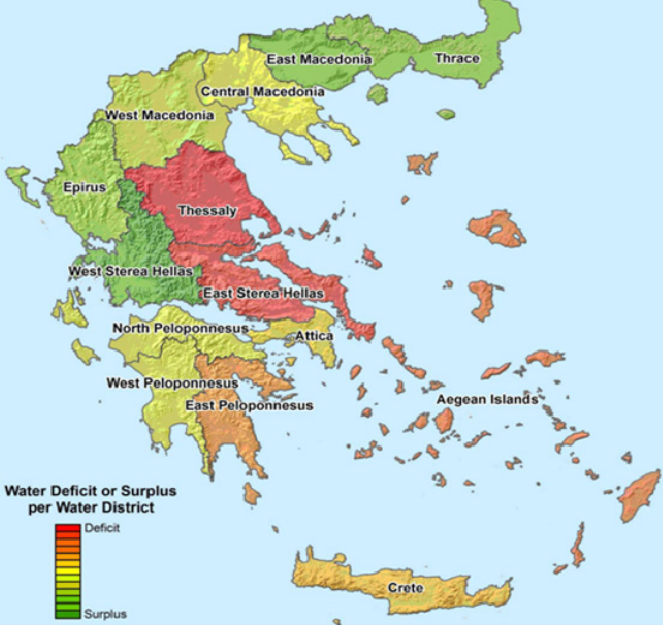
Figure 4. Deficit and/or surplus of potable water per water district in Greece [31]. With permission of Stefopoulou et al . (2008) [31].